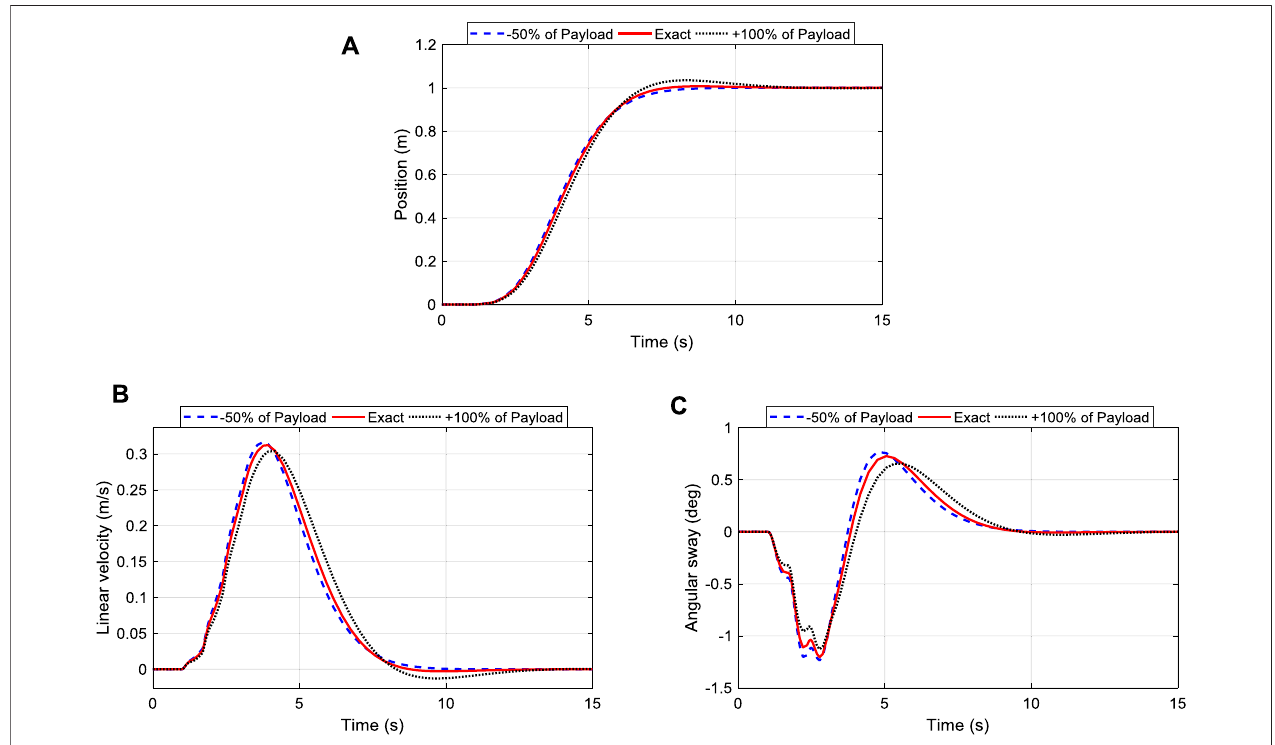
FIGURE 9 | Robustness of iTDC + PPC scheme to changes of payload mass: (A) Position Tracking; (B) Linear Velocity of the roller; (C) Oscillation angle control of the arm.